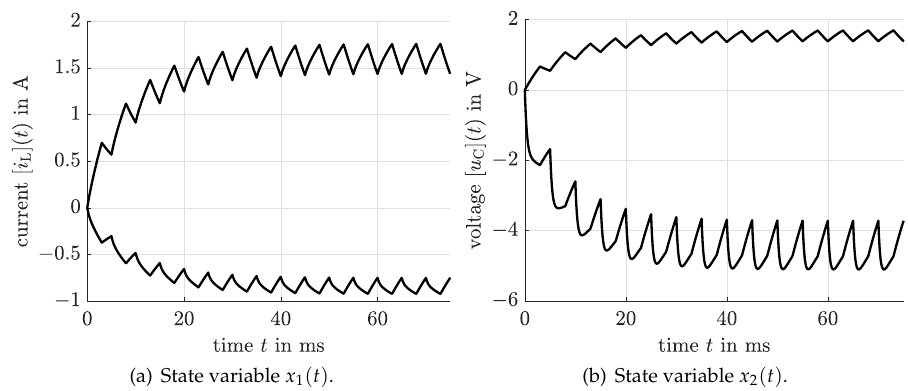
Figure 3. State enclosures in terms of their lower and upper bounds for the step-down converter after backward transformation into the original state-space using the procedure in Section 2.4.